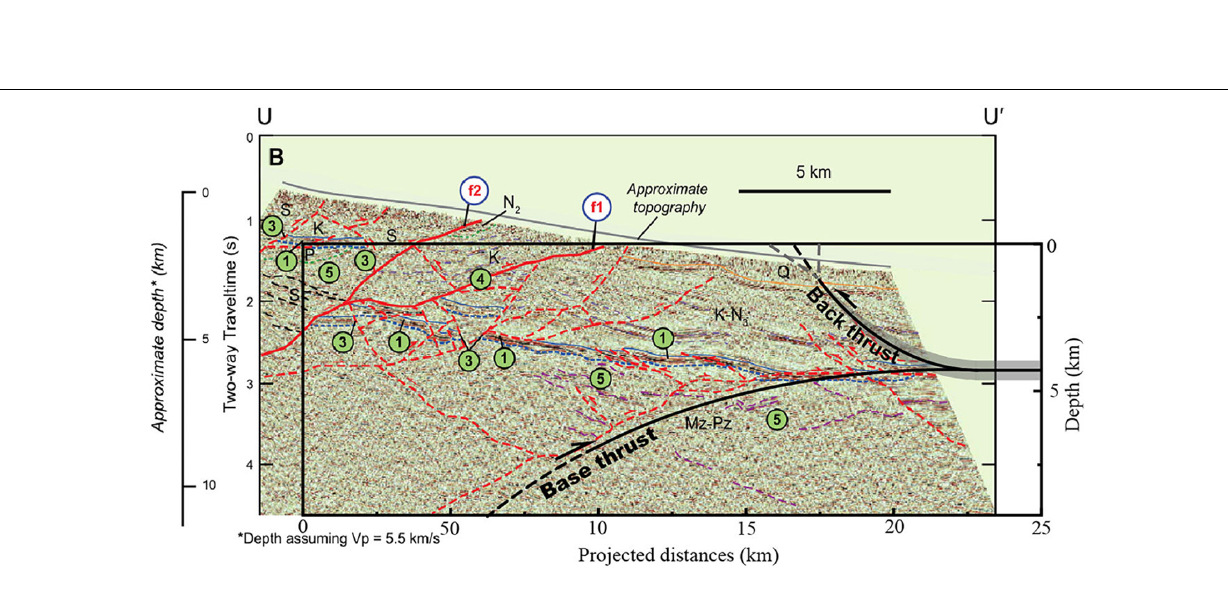
Frontiers in Earth Science |